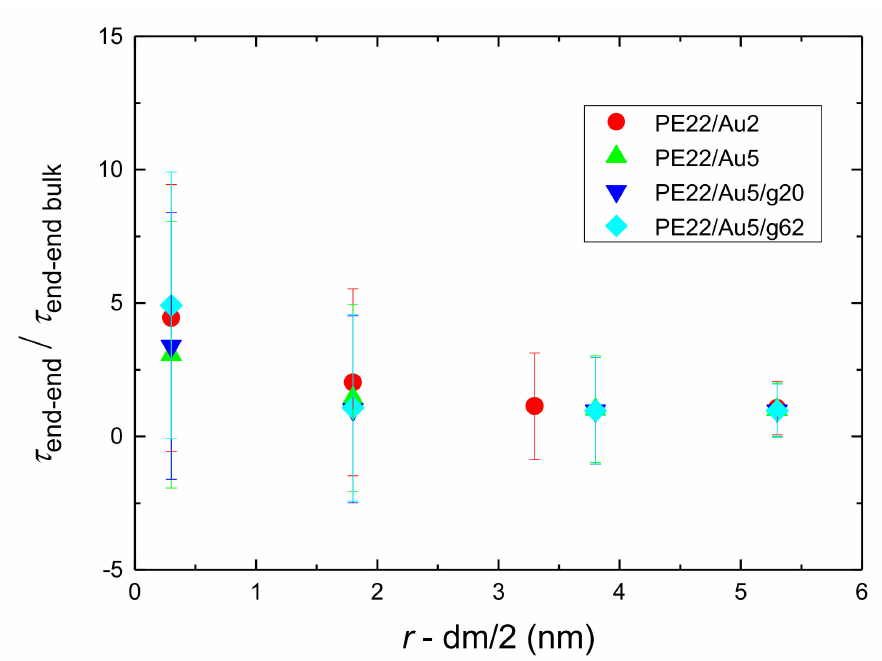
Figure A11. Terminal relaxation times of PE chains derived for the end-to-end vector ACF, C end-end ( t ), scaled with the value of bulk chains, τ end-end / τ end-end bulk , as a function of distance from the center of the Au NP, r , minus the half diameter of the NP for all systems with PE matrices consisting of 22 mers per chain.